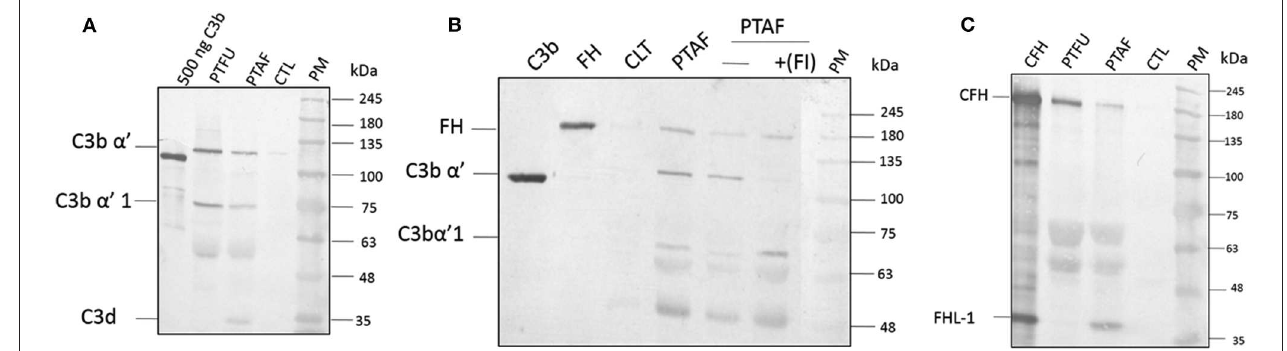
FIGURE 1 | Complement C3, factor H and factor I are present in keratitis patient tear and are functional. (A) C3 protein and its cleavage products in keratitis patient tear. Twelve microgram of tear proteins was separated on a 12% SDS-PAGE and probed with anti-C3 antibody as described in materials and methods. The monoclonal antibody used recognized the C3dg portion of the C3 protein. Lanes 1, Purified C3b (500 ng); 2, Fusarium keratitis patient tear (PTFU); 3, A. flavus keratitis patient tear (PTAF); 4, normal person tear (CTL); 5, protein marker (PM). (B) Alpha chain of C3 is cleaved by patient tear and externally added CFI can accelerate this cleavage. A. flavus swollen conidia (2 × 10 8 ) were incubated with 50 µ g of keratitis patient tear in the presence or absence of Factor I (1.5 µ g) and the supernatant was separated in a SDS-PAGE and transferred to NC membrane. The membrane was probed with a mix of anti-FH and anti-C3 antibodies. Lanes 1, Purified C3b; 2, Purified CFH; 3, Control tear; 4, A. flavus keratitis patient tear (PFTA); 5, A. flavus keratitis patient tear without factor I (FI); 6, A. flavus keratitis patient tear mixed with FI; 7, protein marker (PM). (C) Complement factor H in keratitis patient tear. Twelve microgram of tear protein was separated on a 12% SDS page and probed with anti-CFH antibody in western blots as described in materials and methods. Lanes 1, Purified CFH (500 ng); 2, Fusarium keratitis patient tear (PTFU); 3, A. flavus keratitis patient tear (PTAF); 4, normal person tear (CTL); 5, protein marker